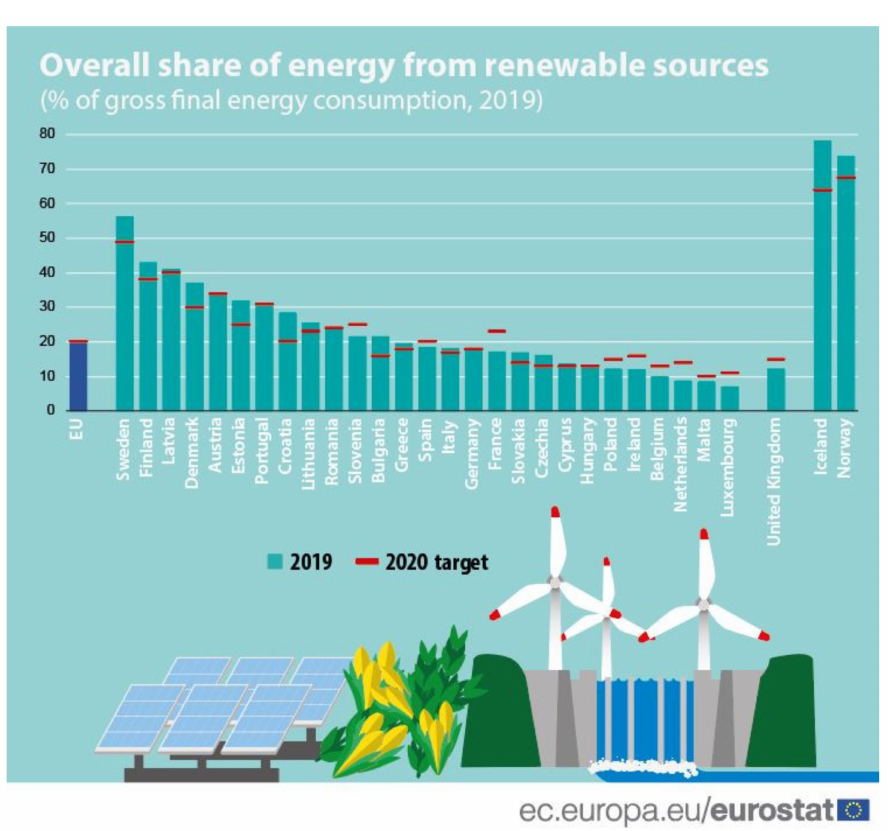
Figure 2. Overall share of energy from renewable sources (source: Eurostat Research,